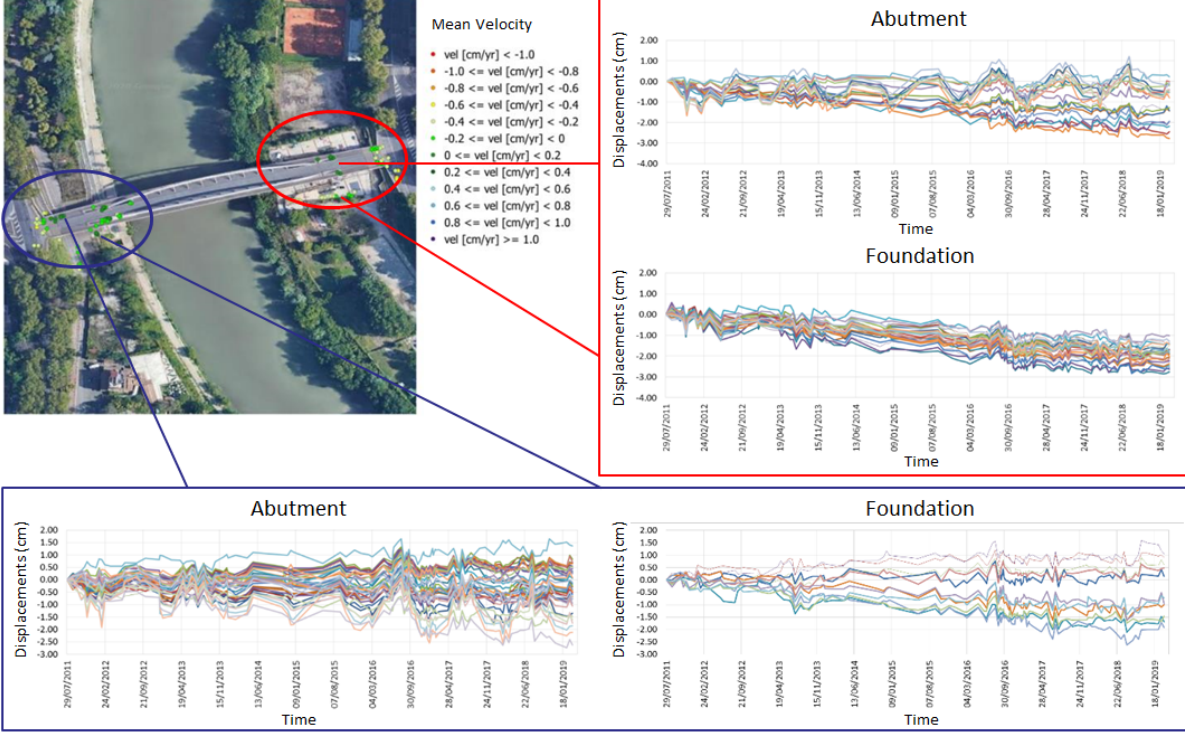
Figure 9. Displacement time-series relating to the measure points located on the bridge abutments and foundation of the west (in blue) and east (in red) bank of the Tiber river — descending orbit.